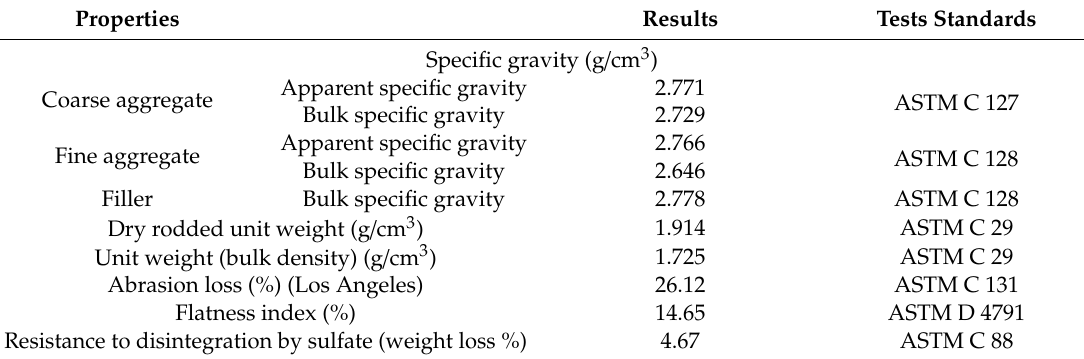
Table 2. Physical, mechanical and durability properties of aggregates.